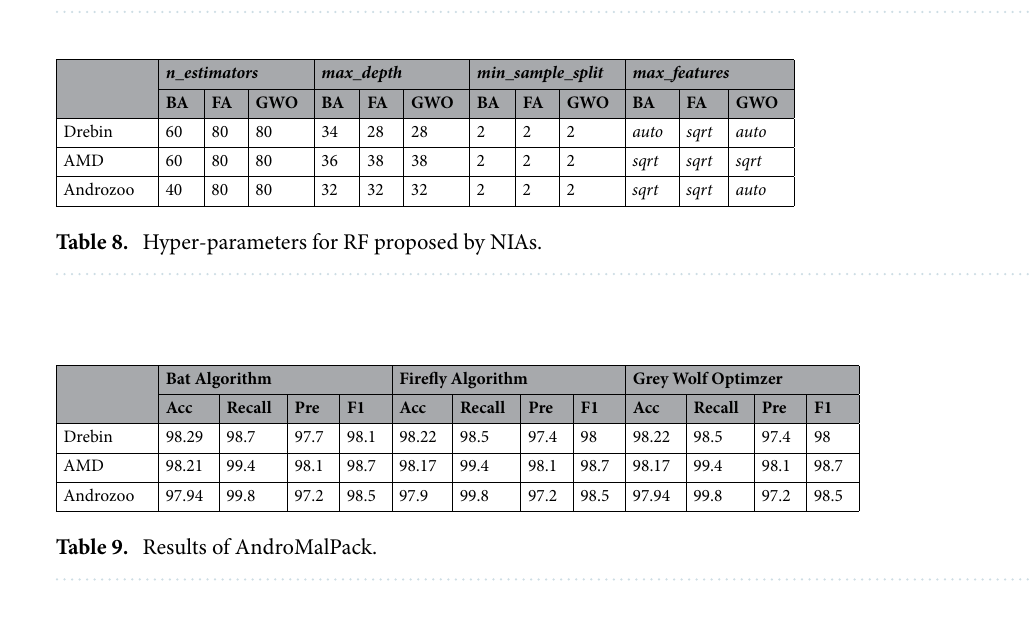
Figure 4. ROC curves of classifiers trained on reduced train sets.